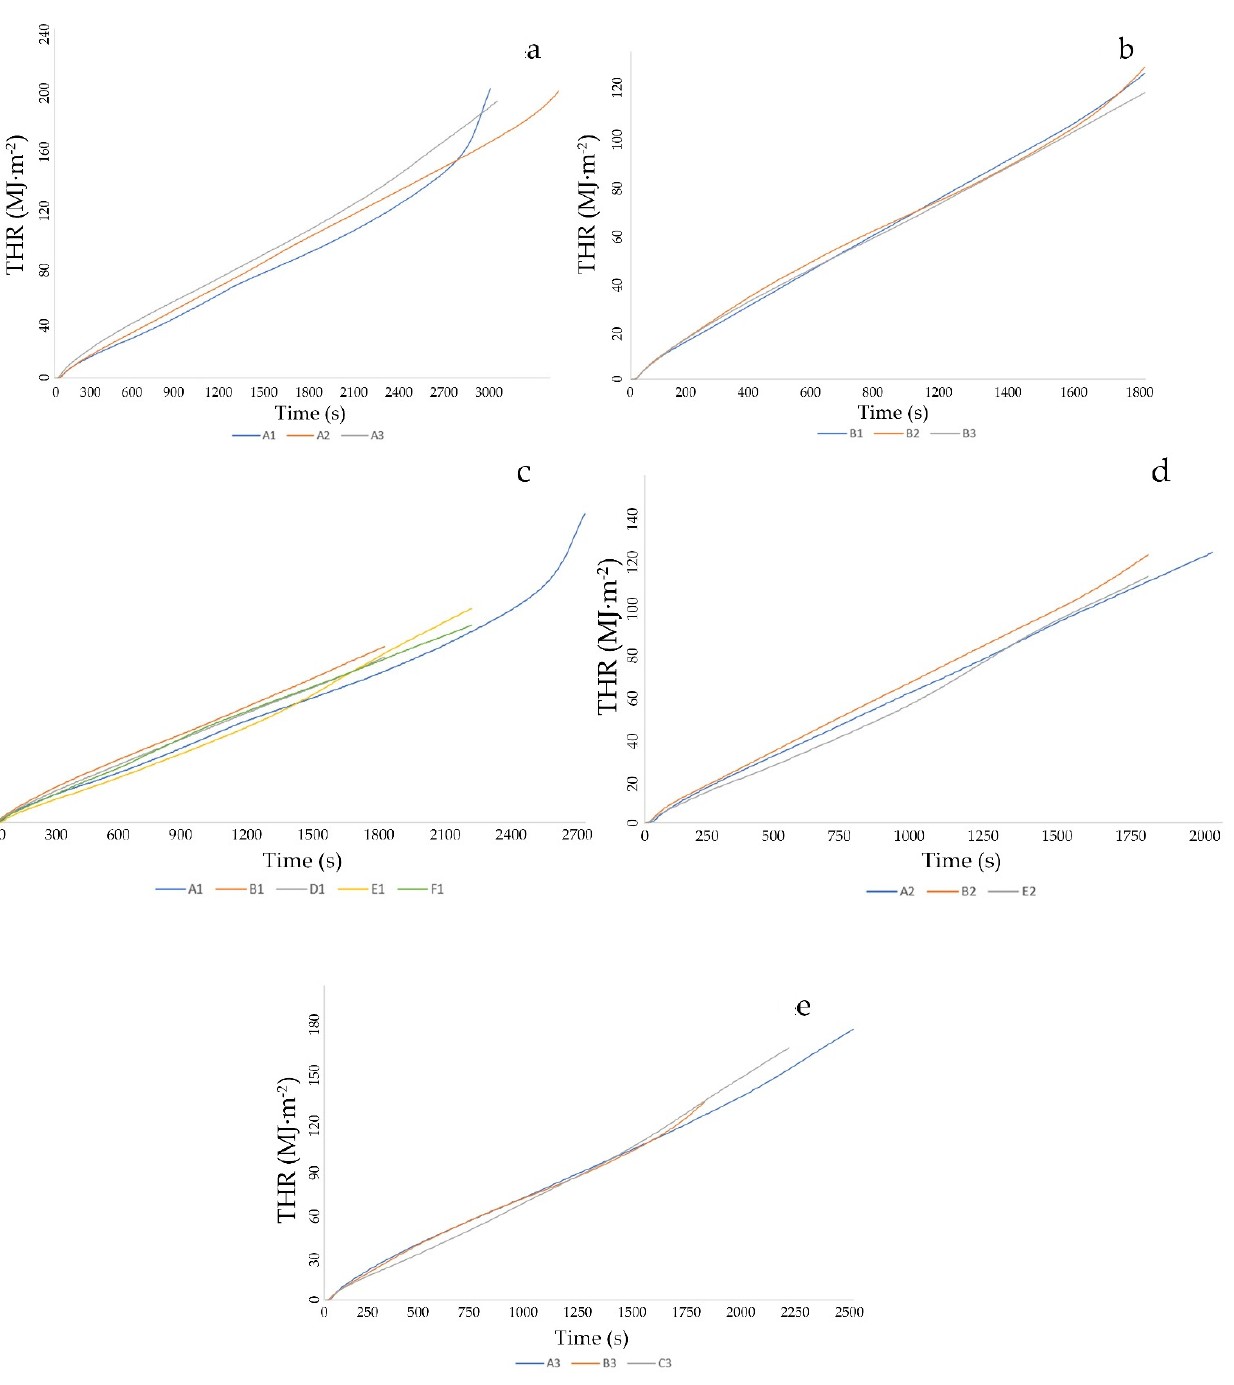
Figure 4. Total heat release of ancient wood with different fractal dimension classes: ( a ) THR of three fractal dimension classes of Ulm, ( b ) THR of three fractal dimension classes of Larch wood, ( c ) THR of five specimens with fractal dimension class 1, ( d ) THR of three specimens with fractal dimension class 2, ( e ) THR of three specimens with fractal dimension class 3.